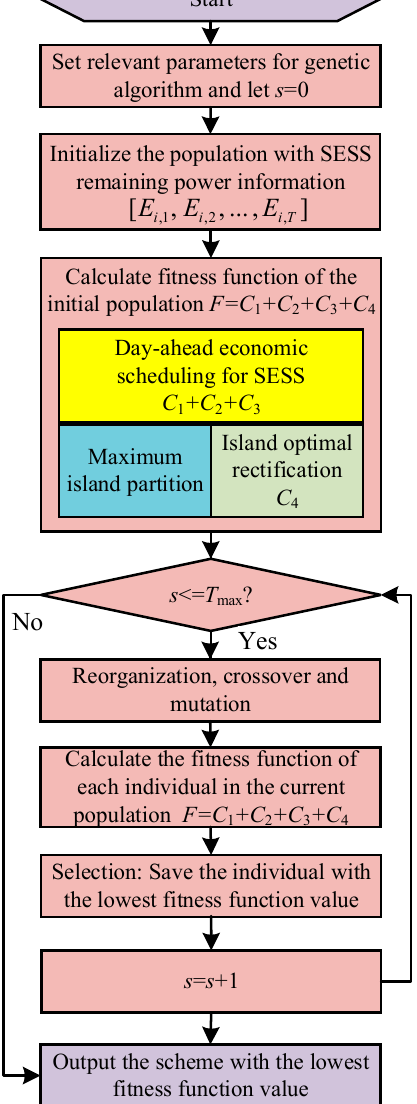
Figure 2. The flow diagram of the SESS optimal scheduling model that considers DN operation risk.